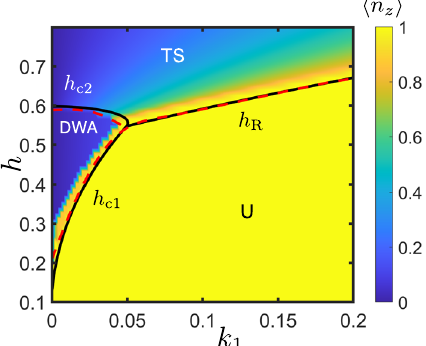
Fig. 3. We also found metastable multiply periodic states: the vortex array with a square lattice (Fig. 5a, b), the vortex chains (Fig. 5c, d) and the hexagonal crystal of coreless vortices (Fig. 5e, f), which can be stabilized by thermal fl uctuations at elevated temperatures.